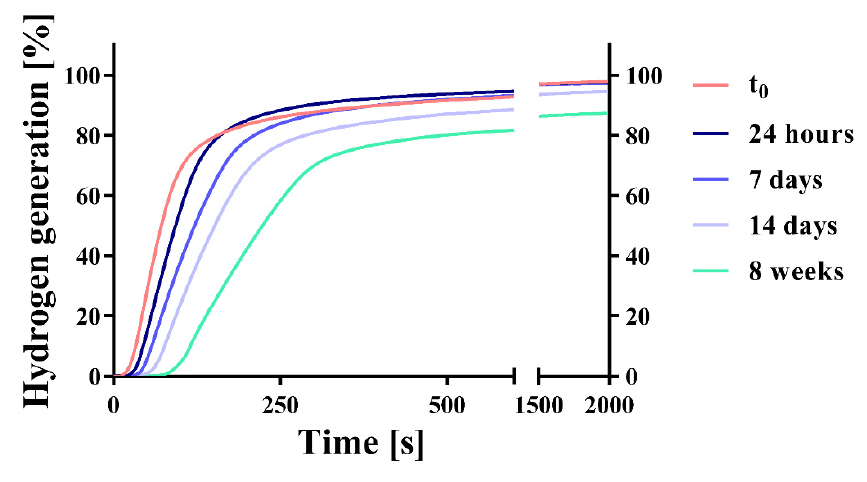
Figure 8. Kinetic hydrogen generation measurement (means; n = 3). Kinetics of hydrogen generation of unpacked tablets of the mannitol/adipic acid-based batch were measured at the starting point t 0 , and after 24 h, 7 days, 14 days, and 8 weeks of storage in a constant climate chamber (25 °C and 60% RH). Table 5. f2 comparison. Kinetic hydrogen generation measurements of the bulk stability samples were compared with the f2 comparison; according to SUPAC guidelines release profiles of tablets with a f2 value between 50 and 100 are considered similar.